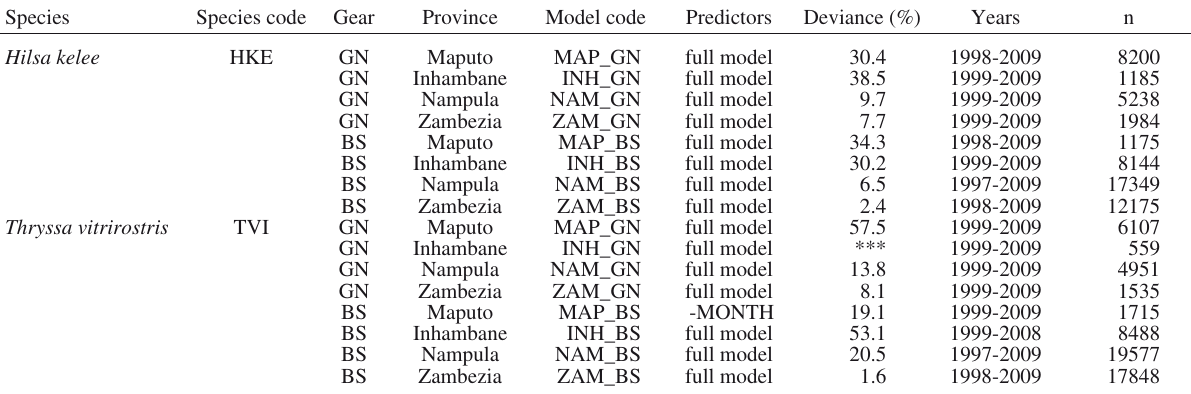
Table 3. – Summary of the results of the GAM models for each species, gear and province analysed. Deviance is the total deviance (in %) explained by the model, Years is the range of years used in the analysis, n is the number of observations used in the model. The model code refers to the results reported in Figures 4, 5 and 6. BS, beach seine; GN, gillnet; ***the model gives unrealistic results and was excluded